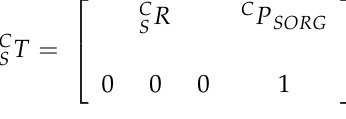
Figure 7. An orthonormal vector v perpendicular to the ground plane described in frame {C}.